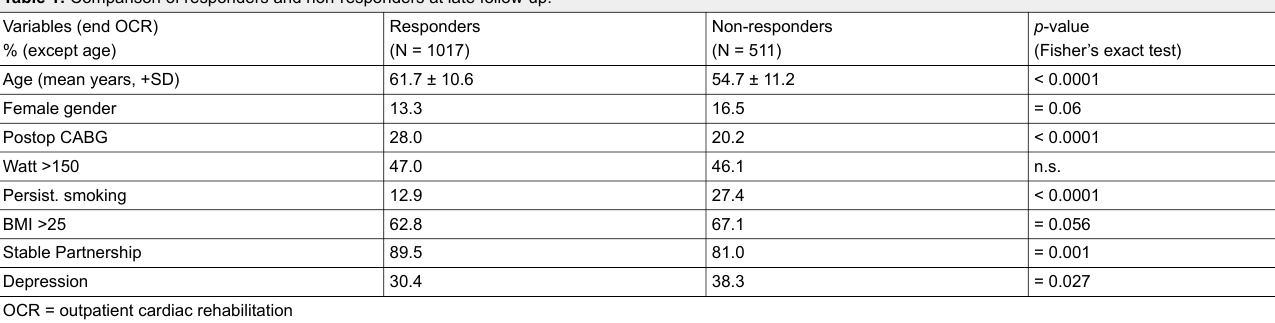
Table 1: Comparison of responders and non-responders at late follow-up. Variables (end OCR) % (except